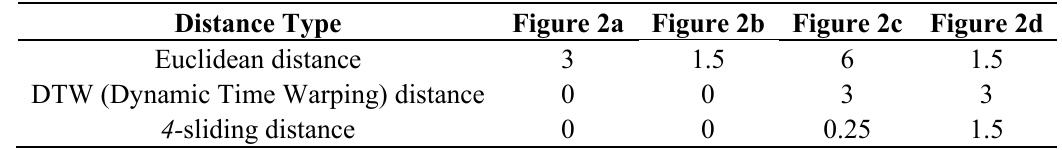
Table 1. Measured distances in the example